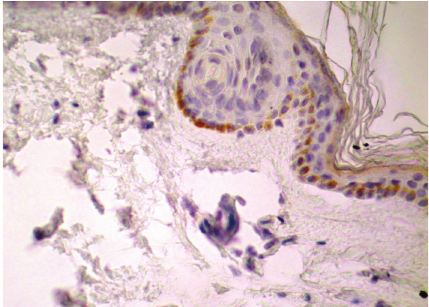
Figure 2: Expression of TF in epidermis. Perilesional skin. Bullous pemphigoid. 400x.